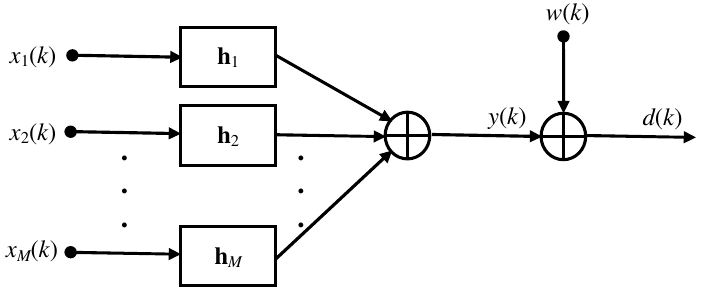
Figure 2. A general block diagram of the LMISO system from